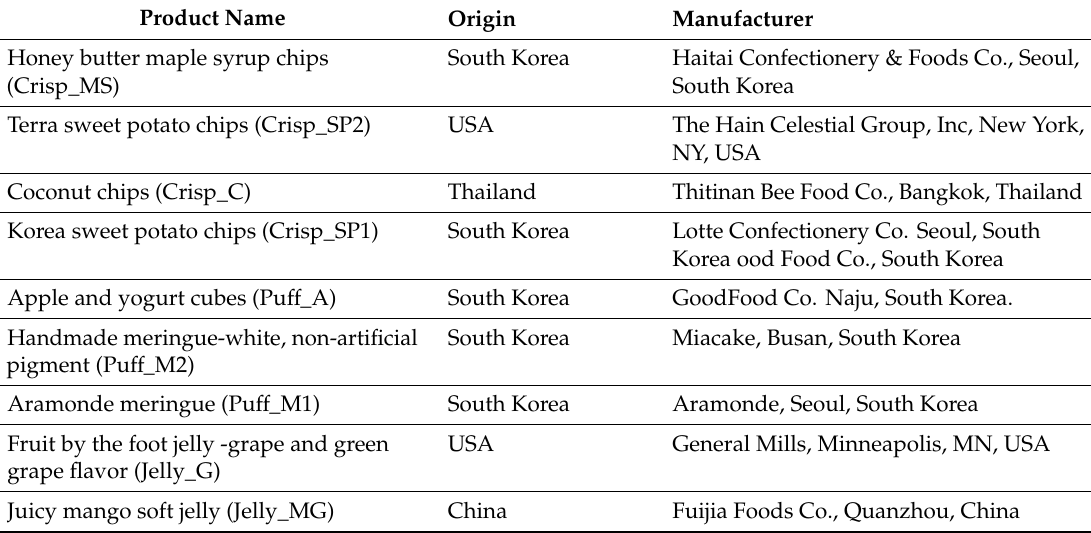
Table 2. Product information for the